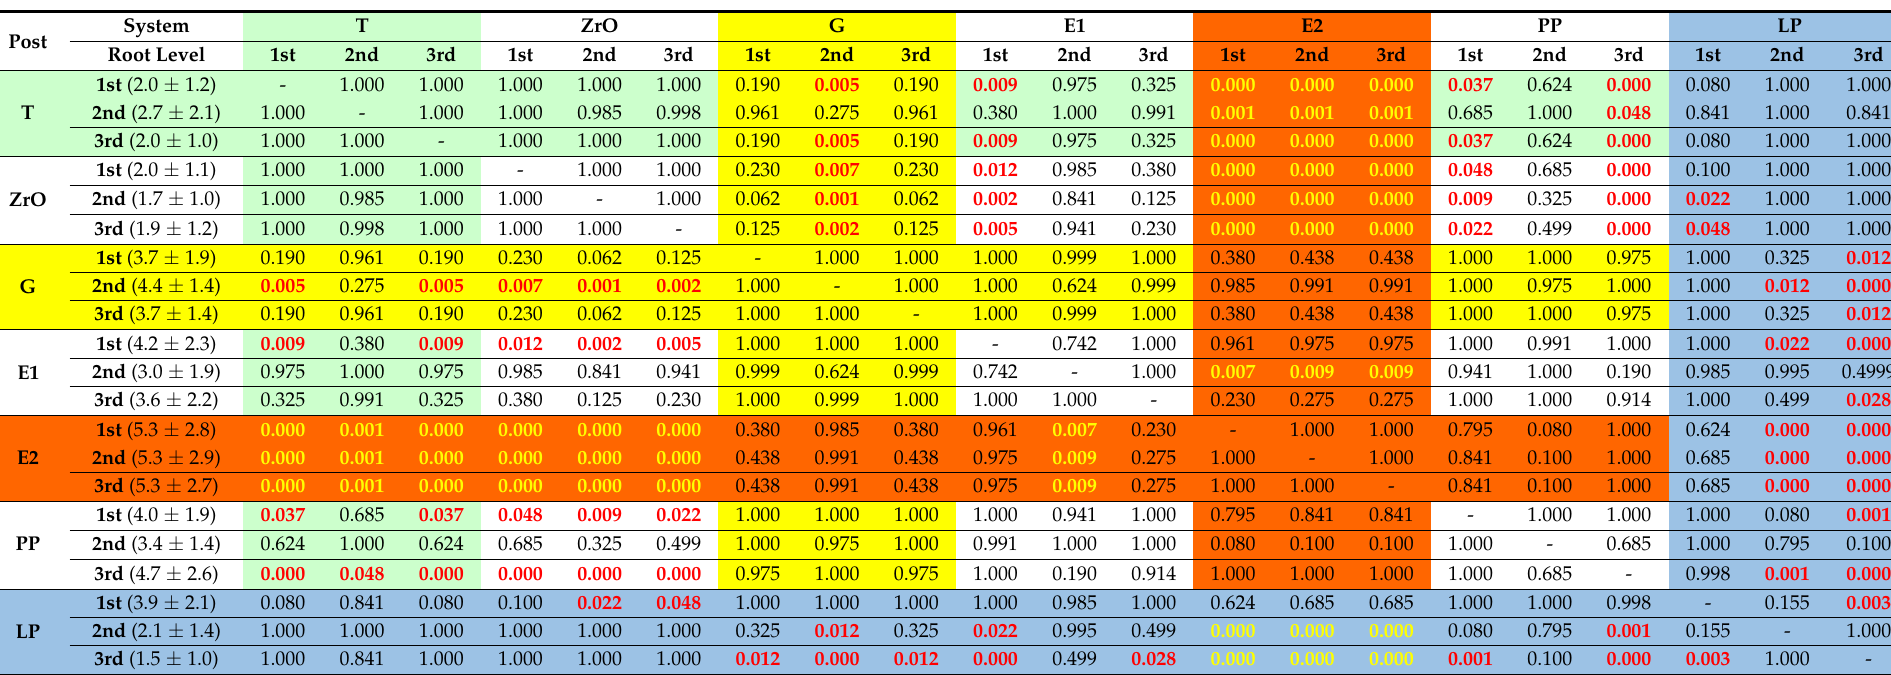
Table 4. Push-out bond strength results (Mean ± SD) MPa and significance values of the mean bond strength values of all post systems T, ZrO, G, E1, E2, PP and LP at all three root levels (coronal (1st), middle (2nd) and apical (3rd) compared to each other. Bold and font values indicate statistical significance ( p <